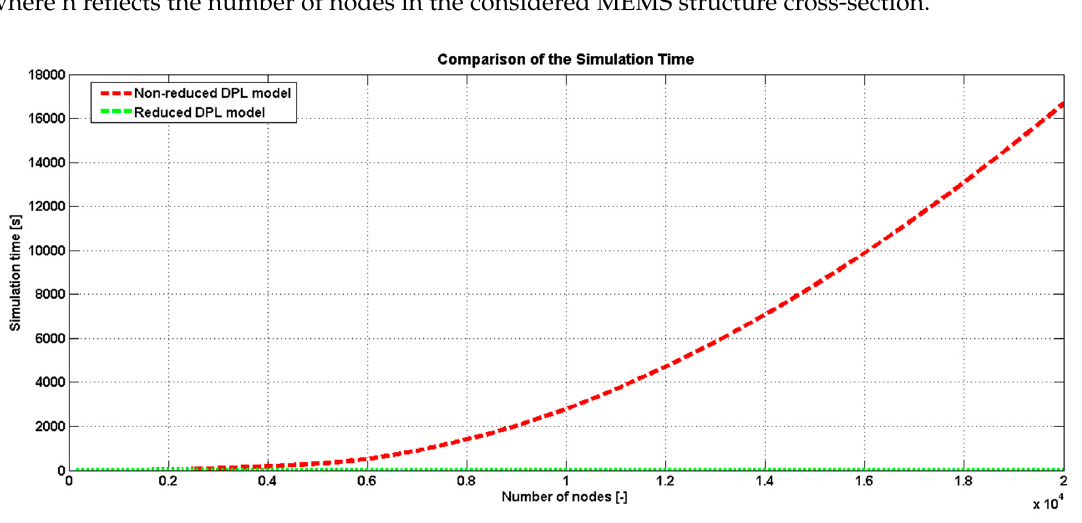
Figure 9. Comparison of the simulation time consumed during the solution calculation in relation to the number of nodes in the analyzed cross-section of the MEMS structure based on the non-reduced and reduced DPL models. Table 2. Simulation time